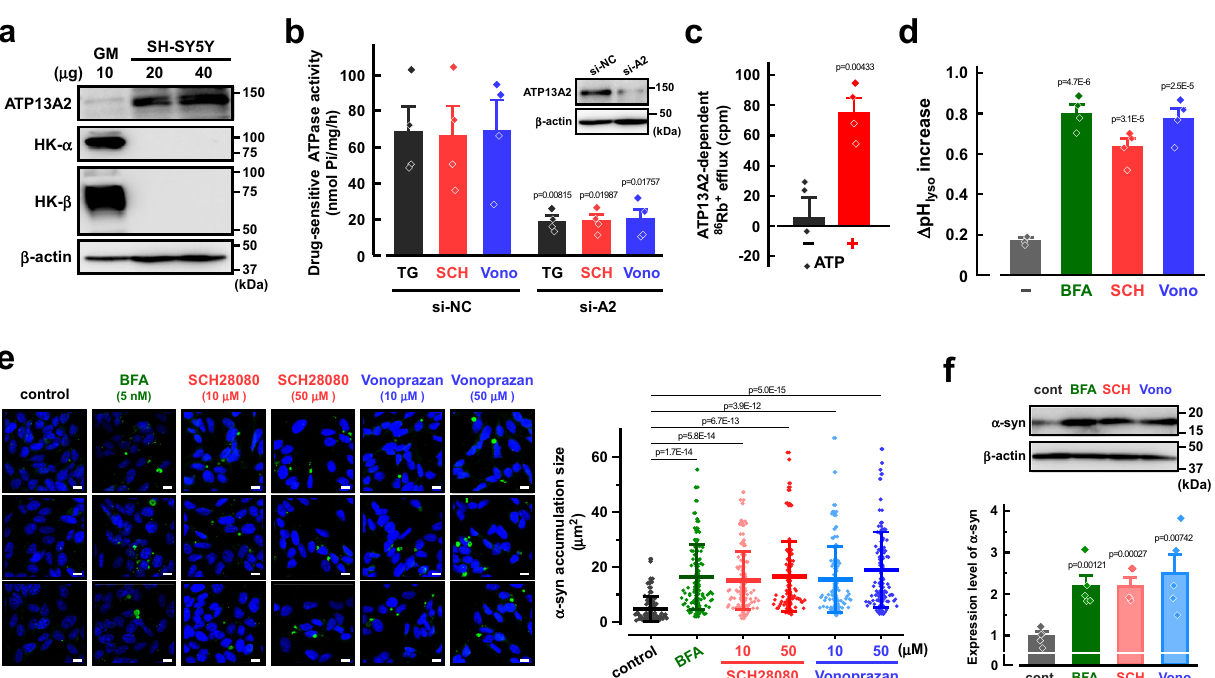
Fig. 4 | Effects of inhibitors of gastric H + ,K + -ATPase (P-CABs) and vacuolar H + -ATPase on endogenous ATP13A2 activity in SH-SY5Y cells. a Expression of ATP13A2, H + ,K + -ATPase α - and β -subunits (HK- α and HK- β ), and β -actin in SH-SY5Y cells and human gastric mucosa (GM). Typical Western blot images in three inde- pendent experiments are shown. b Effects of TG (5 μ M), SCH28080 (SCH; 10 μ M), andvonoprazan(Vono;10 μ M)ontheATPaseactivityintheATP13A2siRNA-(si-A2) or negative control siRNA (si-NC)-transfected SH-SY5Y cells. ( n =4 independent replicates). Insert shows Western blot images for ATP13A2 and β -actin in the cells. Statistical signi fi cance was determined by two-tailed unpaired Student ’ s t test. c TheATP13A2-dependent 86 Rb + ef fl uxfromlysosomesinthepresenceandabsence of ATP. The ATP13A2-dependent component was assessed as the difference between the 86 Rb + ef fl ux in the ATP13A2-siRNA- and negative control siRNA- transfected SH-SY5Y cells. ( n =4 independent replicates). Statistical signi fi cance wasdeterminedby two-tailed unpaired Student ’ s t test. d Effects of ba fi lomycin A1 (BFA; 5nM), SCH28080 (SCH; 50 μ M), and vonoprazan (Vono; 50 μ M) on the lysosomal lumen as a counter-cation of K + . Our phosphorylation assay